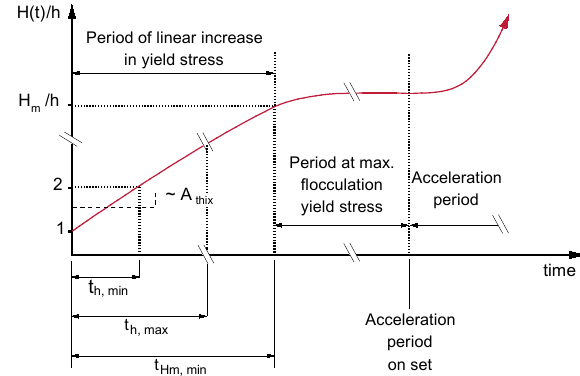
Figure 6. Element height vs. time for digital concrete processes. Initial strength correlates to a yield stress limited by flocculation processes. Hydration at beginning of acceleration process is necessary for higher element height and faster vertical building rates. The rate of thixotropic build up is given as Athix, where A is normalized by the yield stress to sustain a single layer as given in